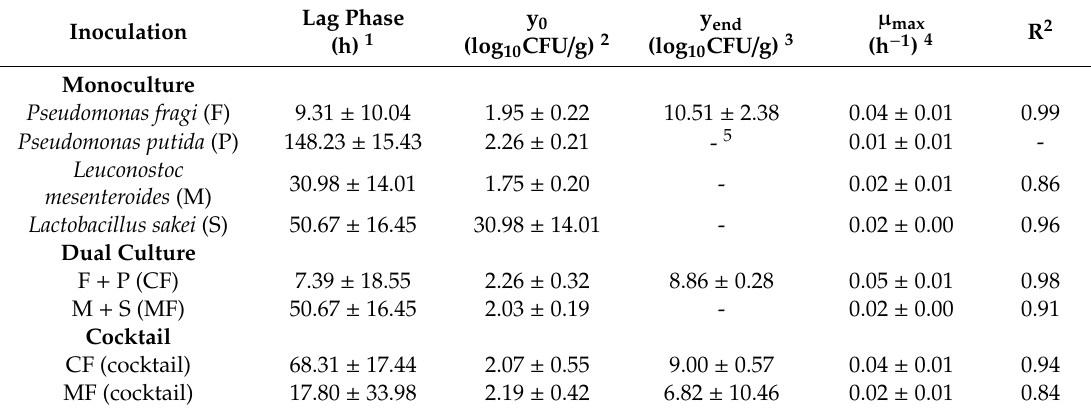
1 : lag phase, 2 y 3 y 4 µ max : maximum specific growth 0 : initial microbial population, end : final microbial population, rate and 5 : not determined. CF: dual cultures of P. fragi and P. putida , MF: dual cultures of Ln . mesenteroides and Lb. sakei . The description of coded treatments is referred to in Table